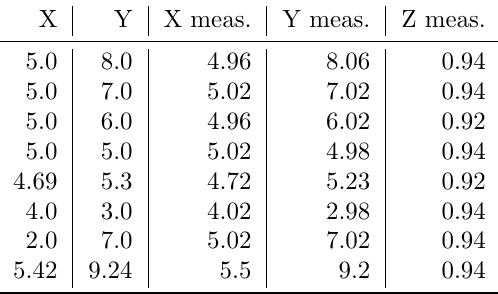
Table 2: A subset of results obtained during the accu- racy validation.